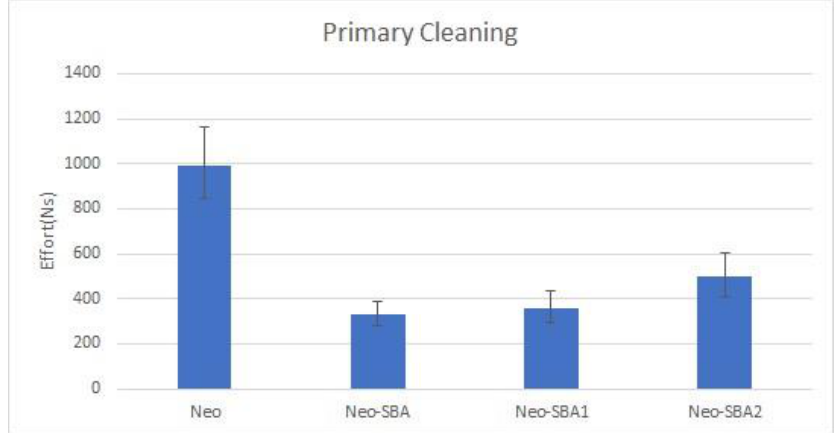
Figure 3. Total cleaning effort based on the ergo-ring test. The first column shows the result for the reference solution without SBA-15.